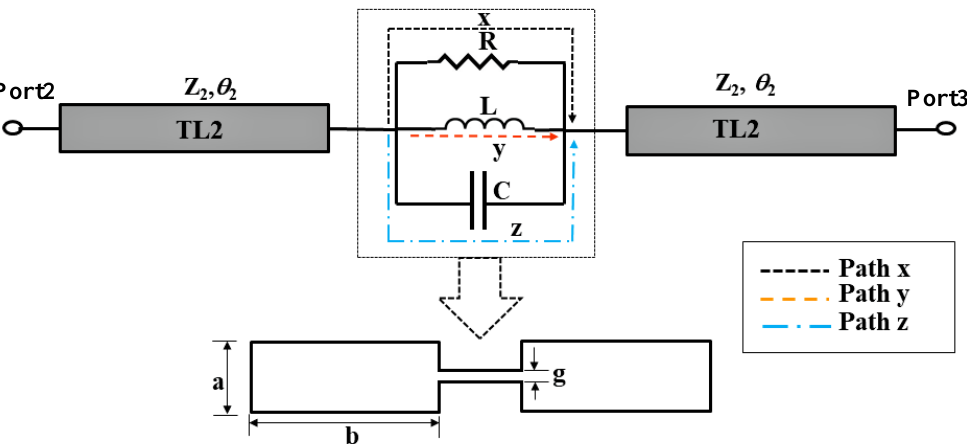
Figure 5. Dumbbell-shaped DGS section between the transmission lines TL2 with its equivalent lumped elements and physical